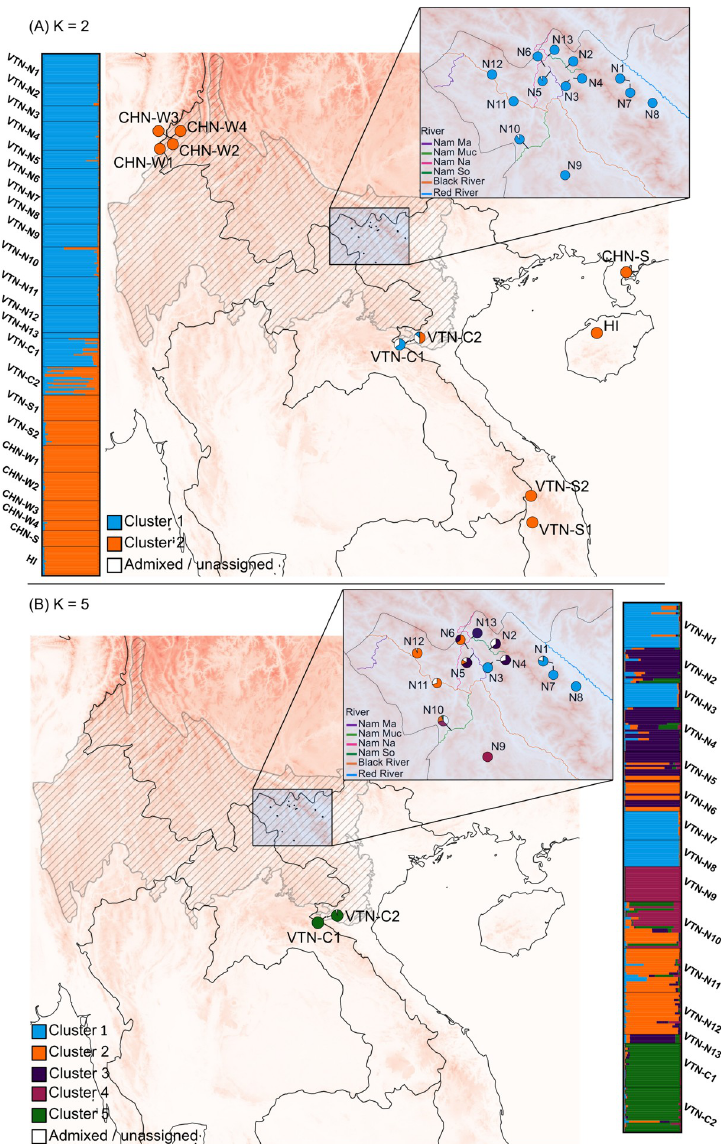
Fig 3. Bar plots indicating cluster assignments obtained with STRUCTURE. Bar plots are presented for the full dataset (A) and the reduced dataset only including native Vietnamese populations (B) with K = 2 and K = 5, respectively. Pie charts indicate cluster assignment values of individuals within each population. White pieces indicate the partition of individuals that could not be assigned to one specific cluster, using an assignment probability threshold of 0.8. Geospatial datasets used for the creation of these maps were reprinted from [59–61] under a CC-BY 4.0 license. high levels of inbreeding [83]. Comparable to population genetic studies of M . balbisiana and other crop species with clonal reproduction capacities [84,85], we found negative inbreeding coefficients (heterozygotic excess) in six populations and overall high levels of within popula- tion variation (53%) versus among population variation (32%). In bananas, excess of heterozy- gosity could be explained mainly by three mechanisms. First, while the species is not self- incompatible, selfing is limited in M . balbisiana due to the way the flowers develop. The flow- ers at the base of the inflorescence are typically female, followed by hermaphrodite flowers